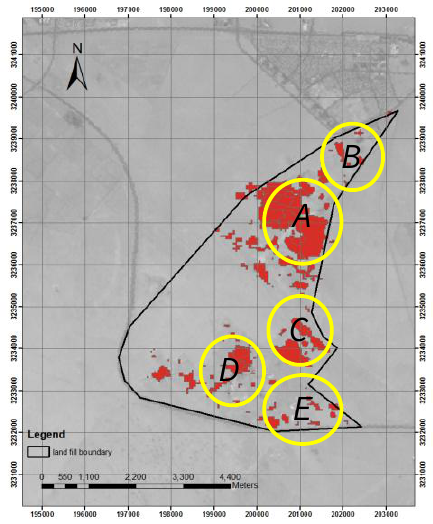
Figure 12. Suspicious Dumping Areas in the Al-Jleeb